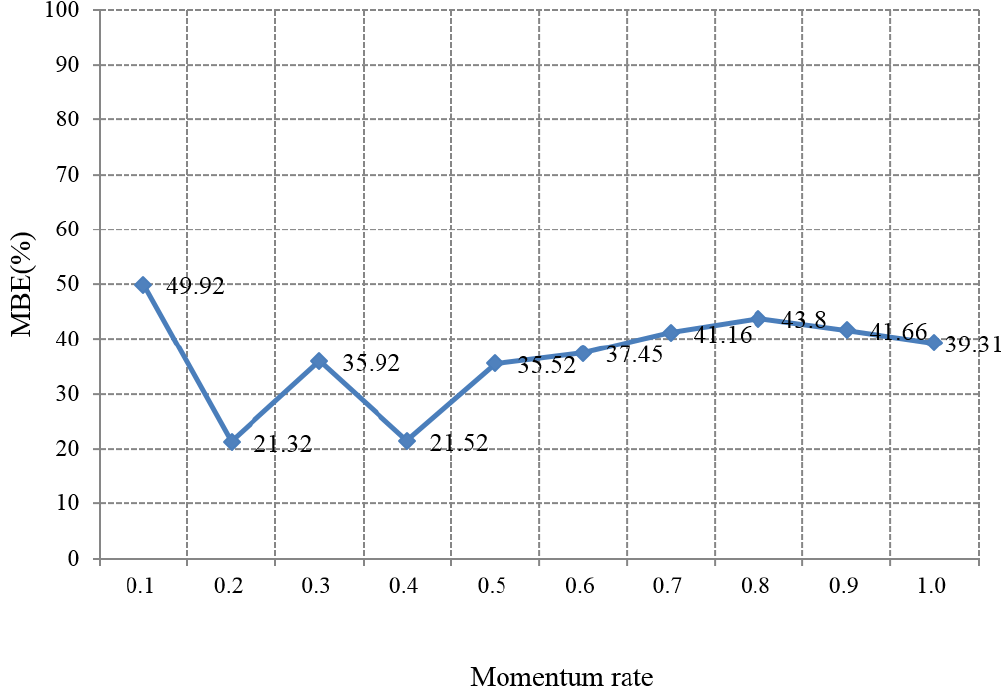
Figure 15. MBE values by momentum